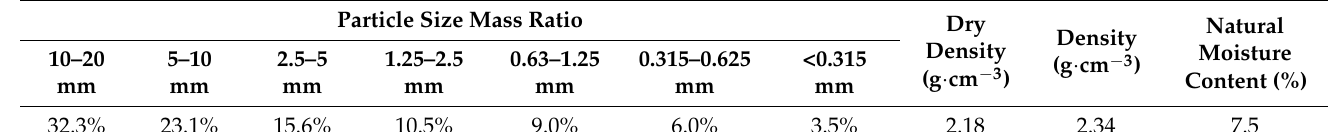
Table 2. Particle size gradation and physical indexes of samples.